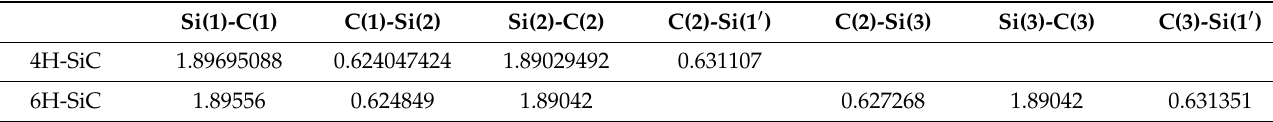
Table 2. Distances between Si and C layers in wurtzite 4H-SiC and 6H-SiC lattices in angstroms relative to the c-axis in Figure